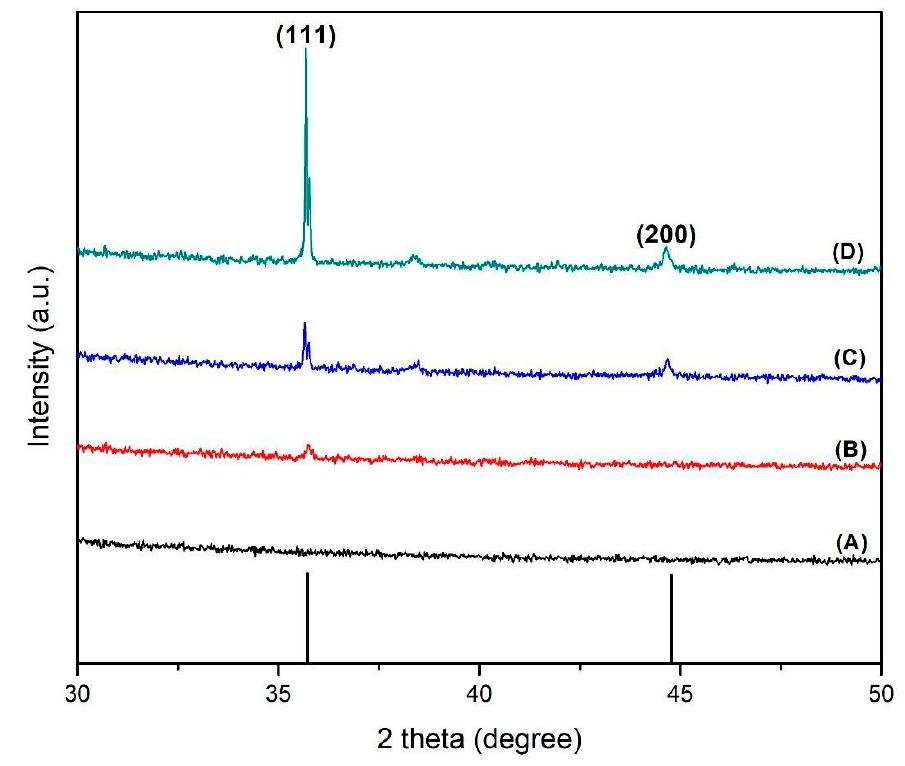
Figure 4. X-ray diffraction patterns of ( A ) pristine Si film, ( B ) 30% Ag–Si film, ( C ) 40% Ag–Si film, and ( D ) 50% Ag–Si and ( D ) 50% Ag–Si film.